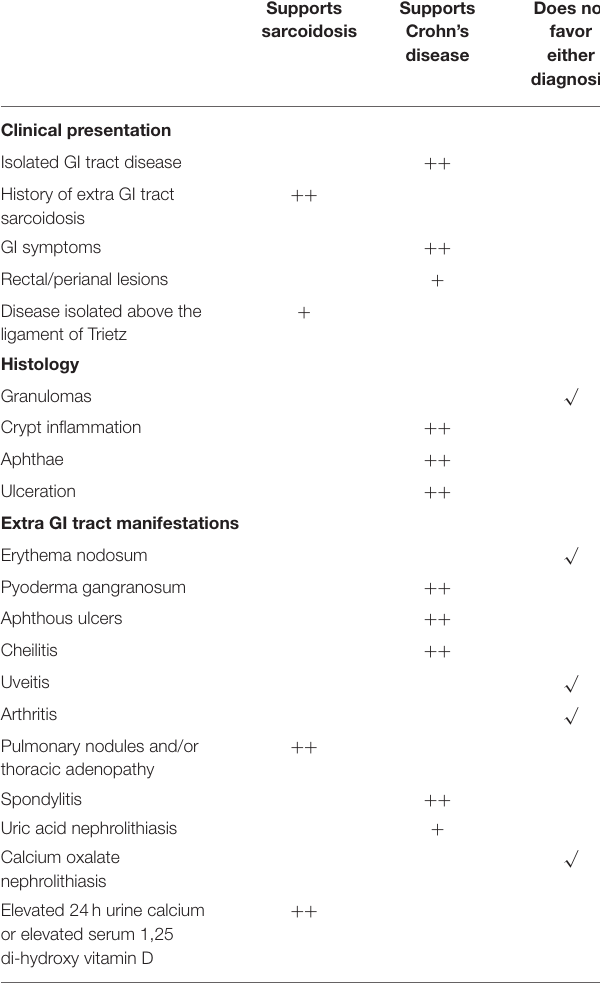
TABLE 4 | Clinical data supporting the possibility of sarcoidosis vs. Crohn’s